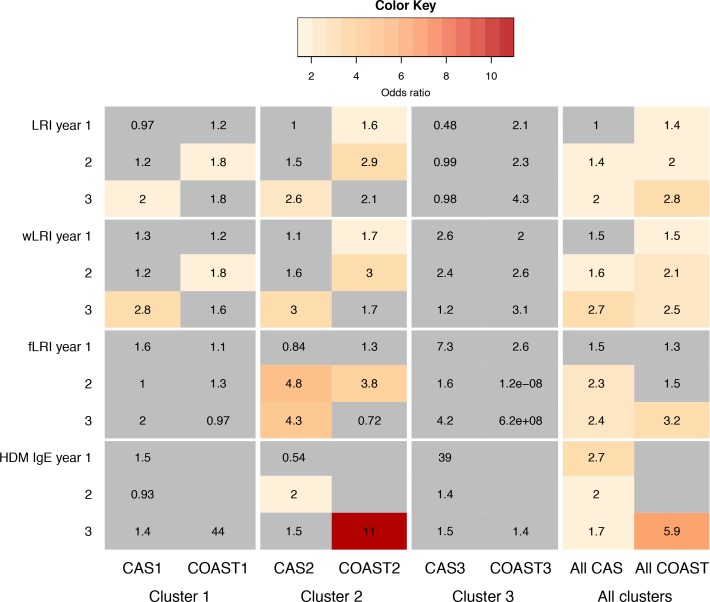
Comparison of predictors for age-5 wheeze in CAS and COAST clusters.Colour coding and numbers in cells indicate odds ratio (OR) of predictor for age-5 wheeze in GLM, with sex, maternal and paternal history of asthma, and (for CAS) BMI as covariates. Non-grey cell with number indicates statistically significant association (p<0.05). Grey cell with number indicates non-significant (p>0.05); grey non-numbered cell indicates test not done due to lack of data.